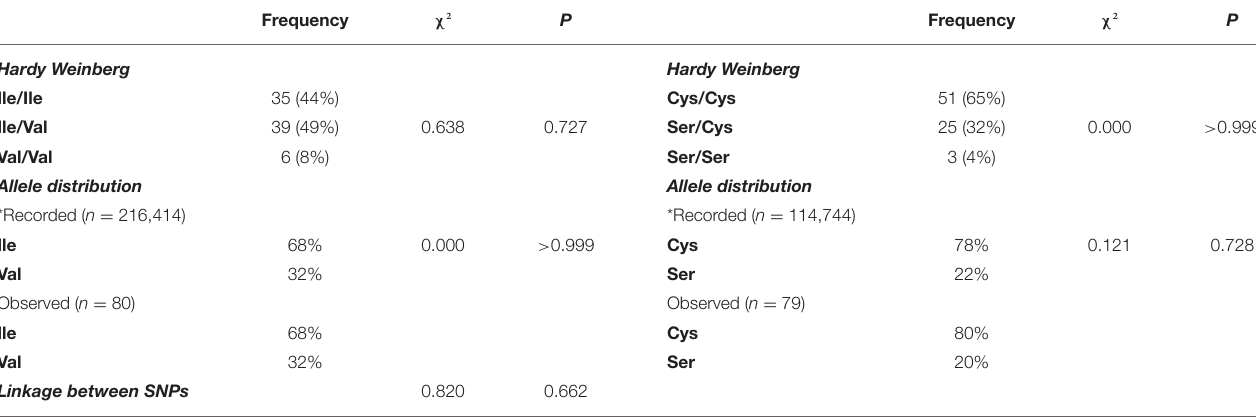
TABLE 1 | Allele frequency, distribution and linkage of